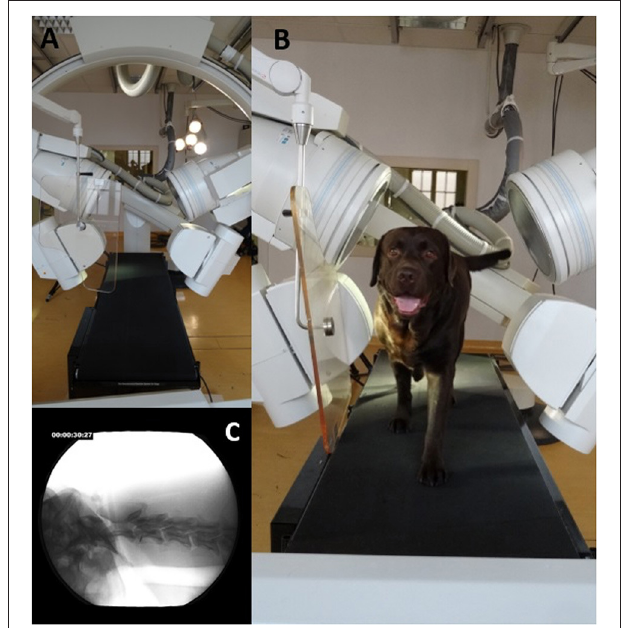
FIGURE 2 | Fluoroscopy 63 ◦ experimental setup. (A) : 63 ◦ fluoroscopy setting to record the oblique-laterolateral beam path. The treadmill is located in the center. (B) : Labrador retriever walking on the treadmill located in the beam path. (C) : X-ray video view of the oblique-laterolateral beam